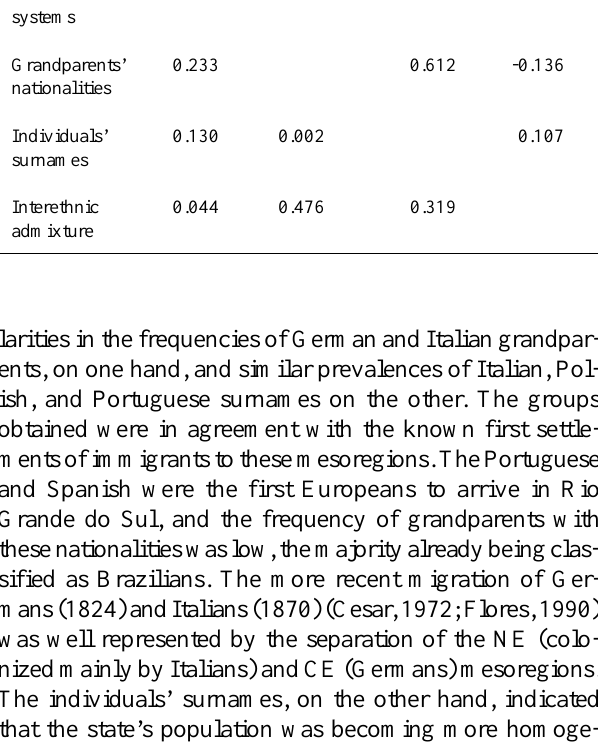
distances, (c) map of A